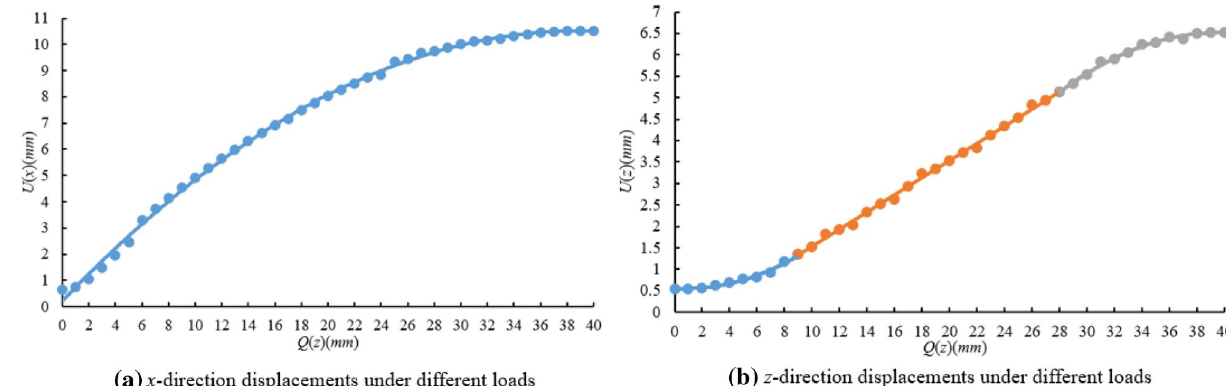
Fig. 6 Displacements under